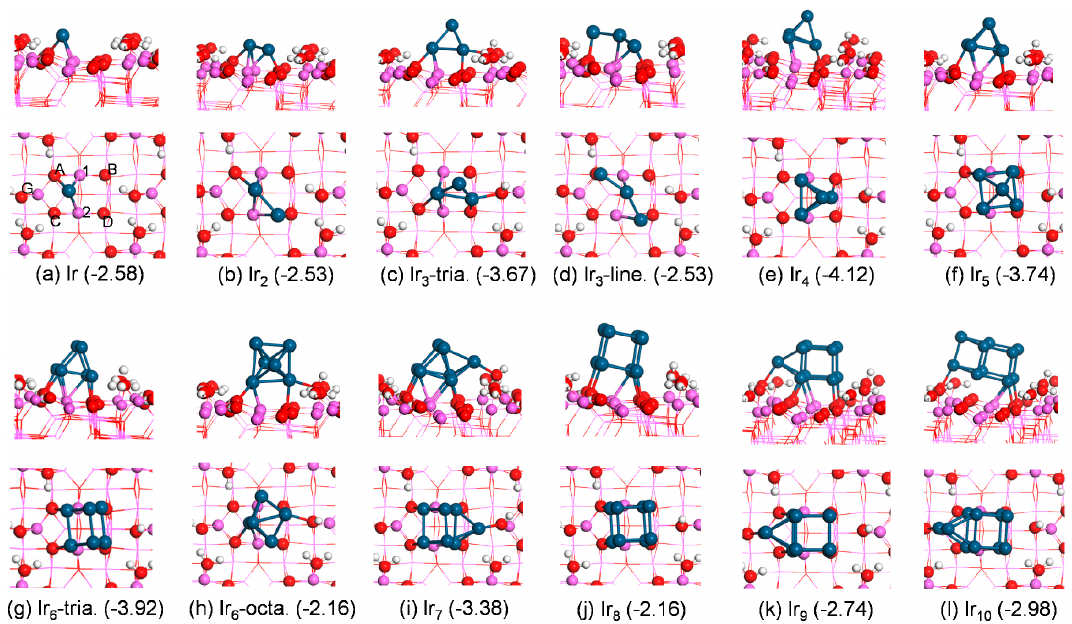
Figure 2. Side (top) and top views (bottom) of the most favorable Ir n ( n = 1–10) adsorption structures with the corresponding adsorption energies E ads (in eV) on the hydrated γ -Al 2 O 3 (110) surface. Largest spheres: Ir; the other color/label scheme is identical to Figure 1.